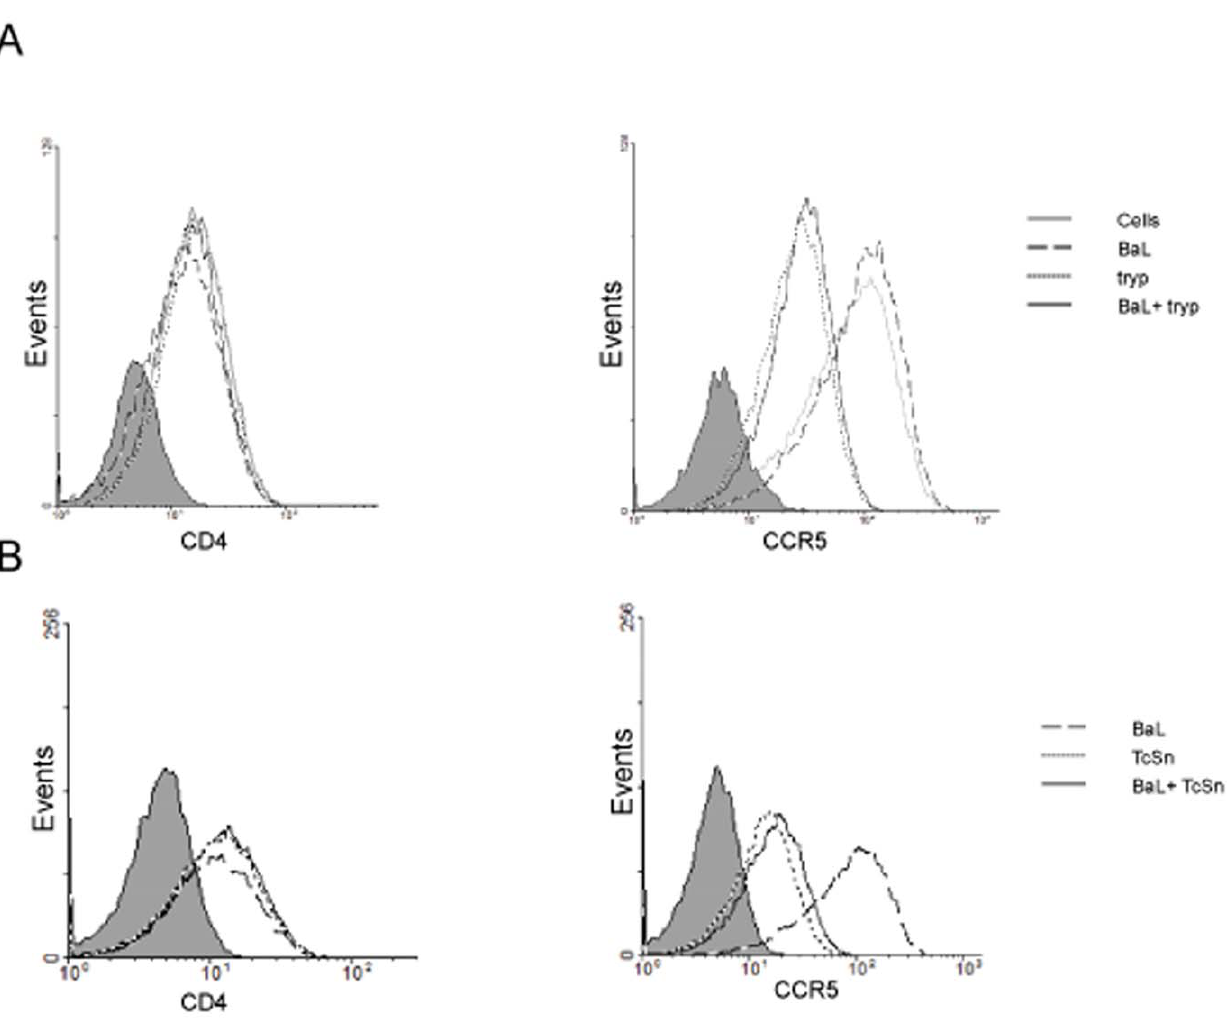
Figure 7. CCR5 expression impaired by T.cruzi . Expression of the cell surface of CCR5 and CD4 was evaluated on MDM infected or coinfected with ( A ) T. cruzi trypomastigotes or ( B ) TcSn. After overnight infection, cells were harvested, and CCR5 and CD4 expressions were assayed by flow cytometry. Histograms in grey correspond to isotype control. Results are representative of 4 independent experiments performed with cells from different donors.